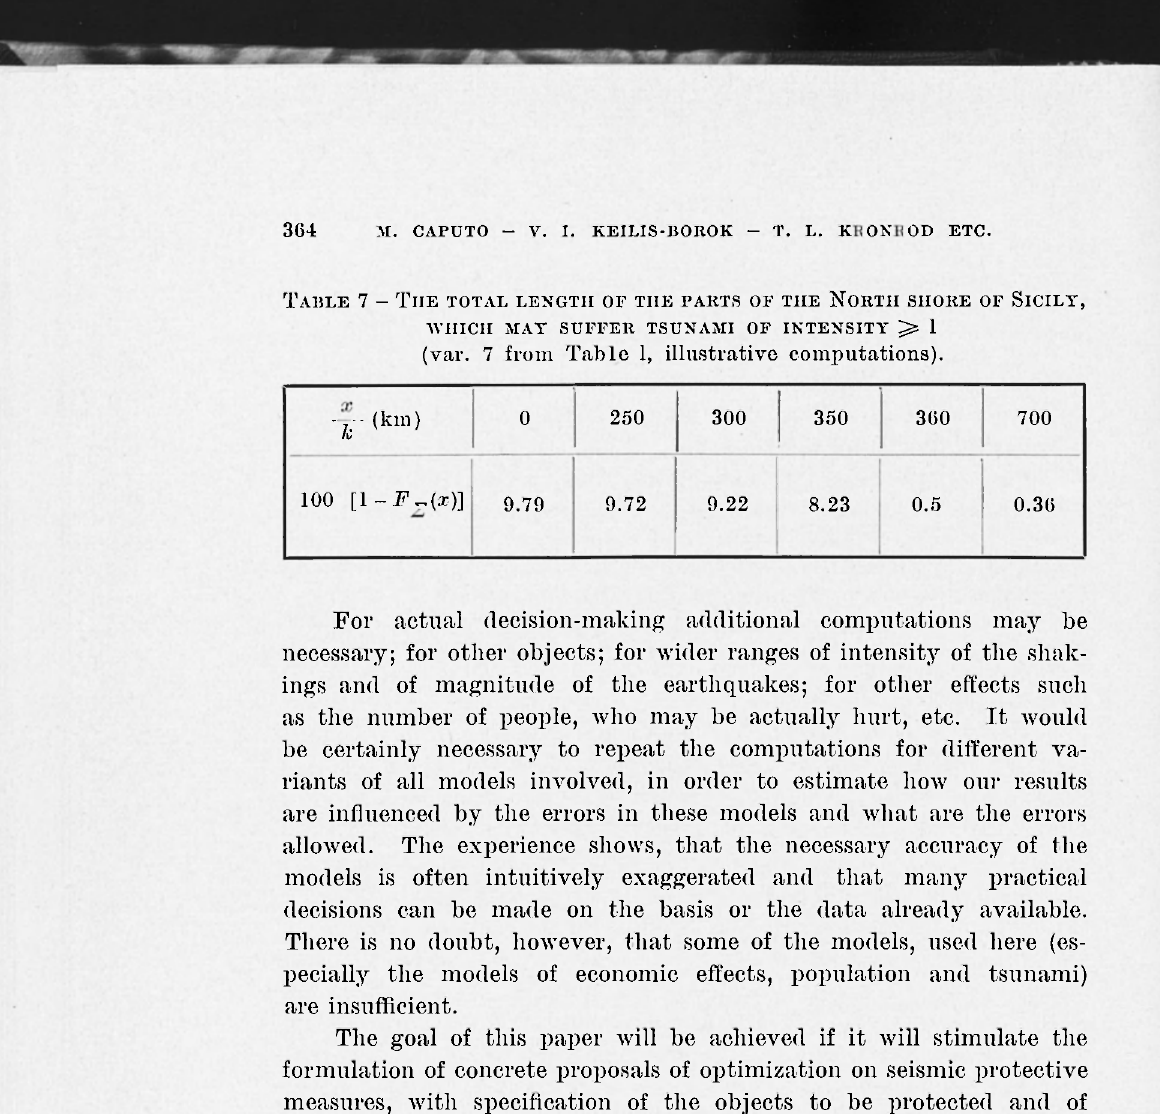
TABLE 7 - TIIE TOTAL LENGTH OF THE PARTS OF THE NORTH SHORE OF SICILY, WHICH MAY SUFFER TSUNAMI OF INTENSITY J? 1 (var. 7 from T a b le 1, illustrative computations).